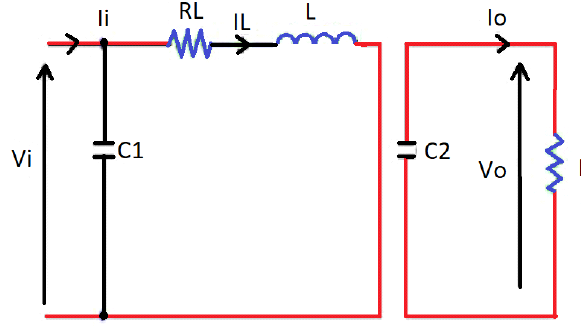
Figure 4. ON state operation.